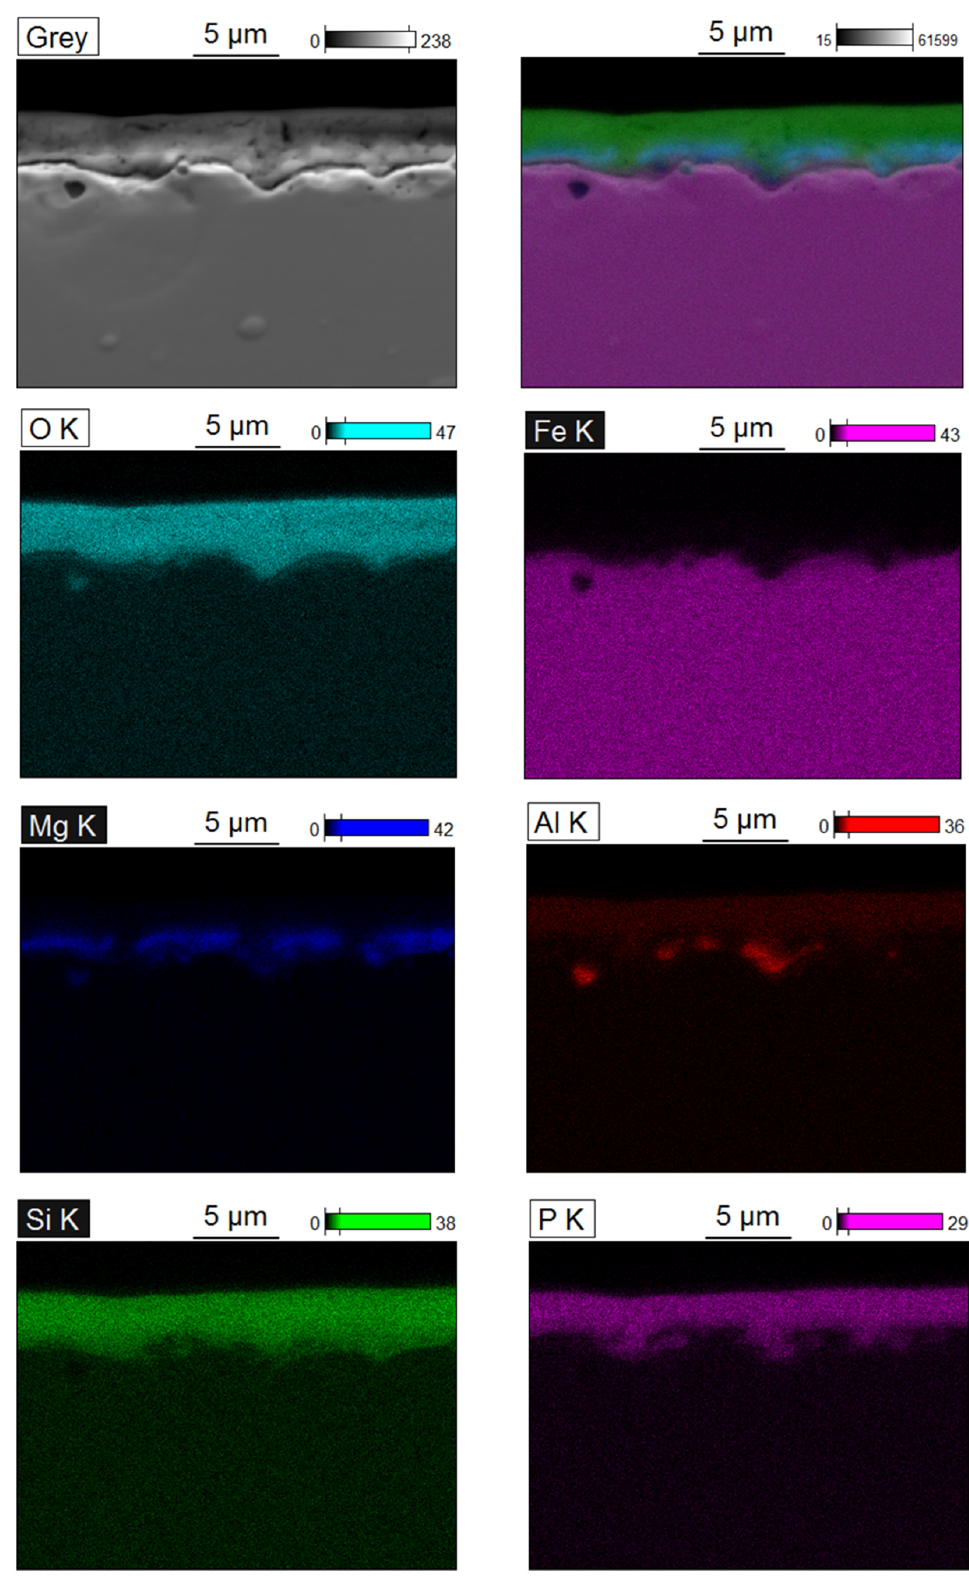
Figure 3. Elemental mapping of cross-section of surface layer of H 23#1 obtained during the carried-out tests.